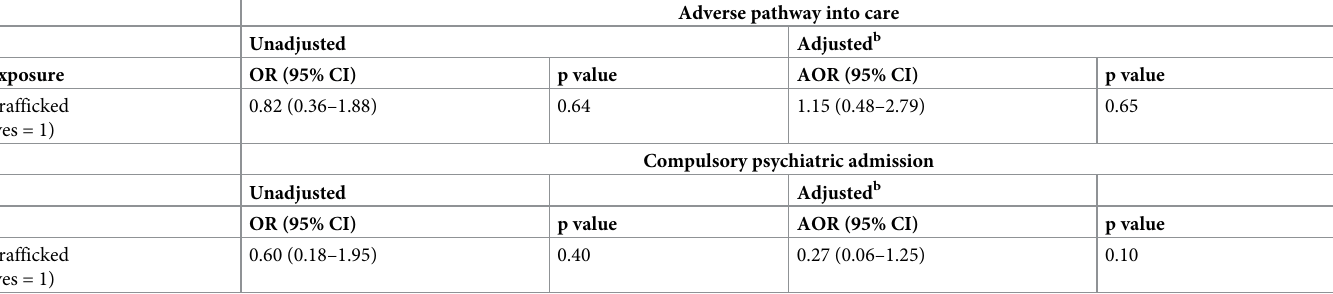
Table 3. Logistic random effects regression analyses comparing care pathways of trafficked and matched non-trafficked children in contact with secondary mental health services a .